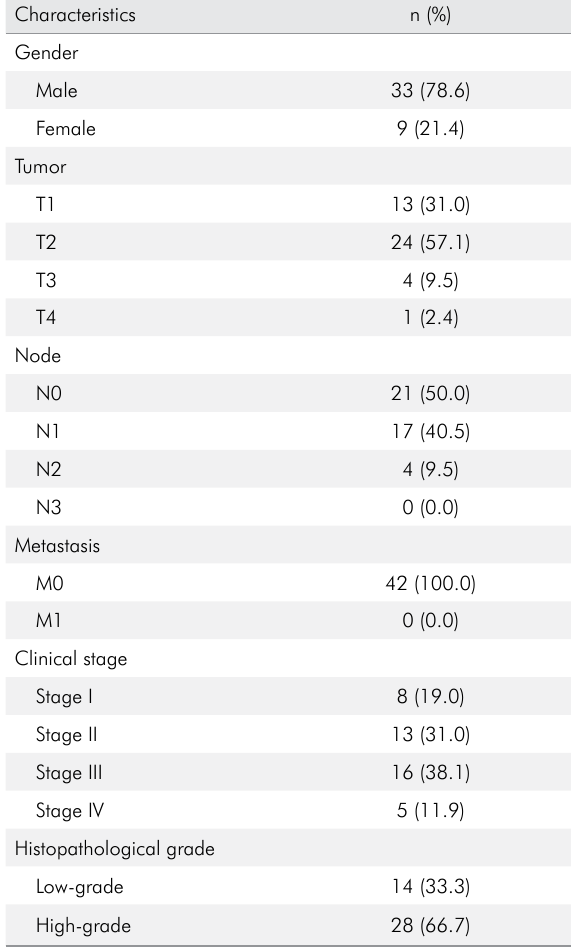
Table 2. Distribution of cases of lower lip squamous cell carcinoma according to clinicopathological